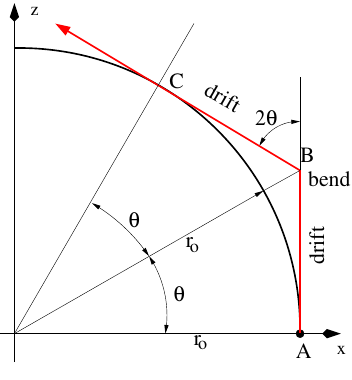
Figure 2. Leapfrog bend cell: drift, kick-bend,